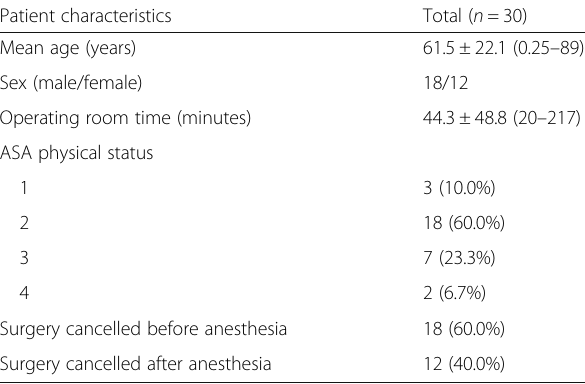
Table 3 Cases surgery cancelled before anesthesia and cause of